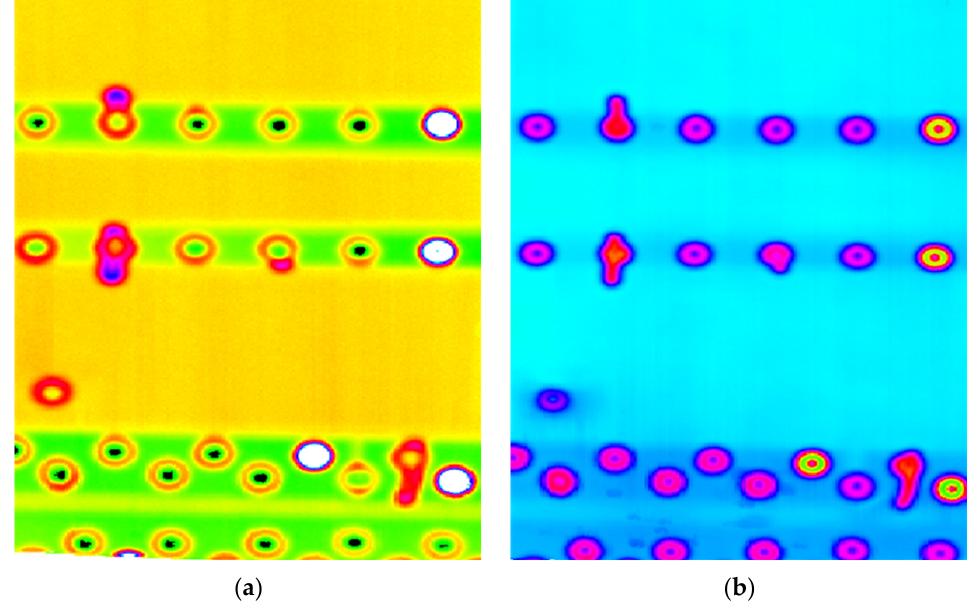
Figure 2. Eddy current scan of the region of interest obtained for the 20 kHz excitation signal: ( a ) imaginary part; ( b ) real part.